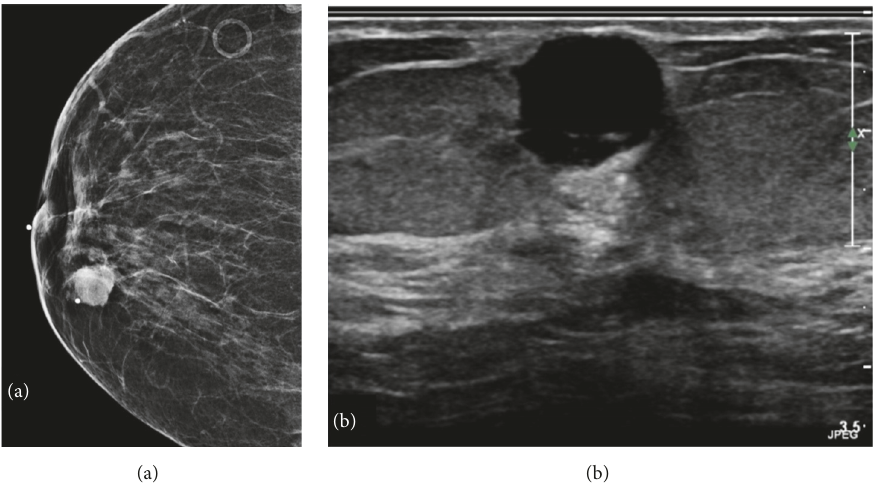
Figure 1: (a) Mammography, left breast: multinodular 19 mm predominantly solid lesion. (b) Ultrasonography, left breast: 19 x 13 x 12 mm complex solid and cystic lesion with internal vascularity located 2 cm from the nipple at 1:00 axis.